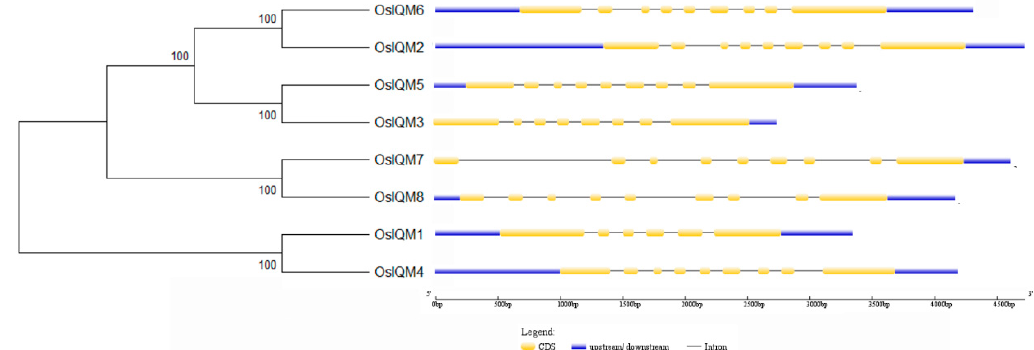
Figure 2. Phylogenetic relationship and exon–intron organization of rice IQM genes. The unrooted phylogenetic tree of eight rice IQM proteins was constructed by the NJ method with 1000 bootstrap replicates. Exons and introns are represented by yellow boxes and black lines, respectively. Untranslated regions (UTRs) are indicated by blue boxes. The sizes of each IQM gene can be estimated using the scale at the bottom.